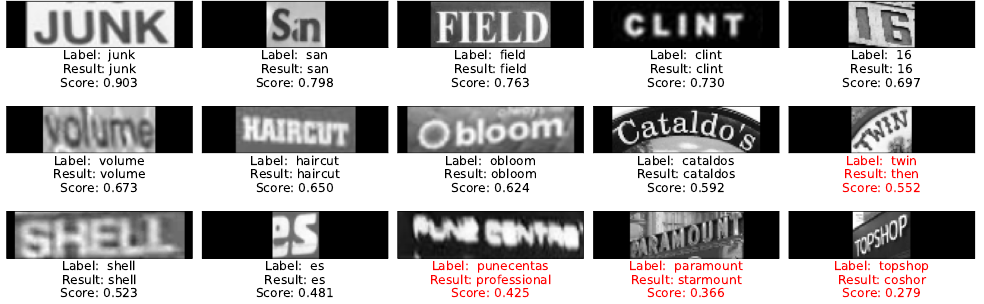
Figure 9. Samples text images from benchmarks with the corresponding quality scores, recognition ground truth, and results.